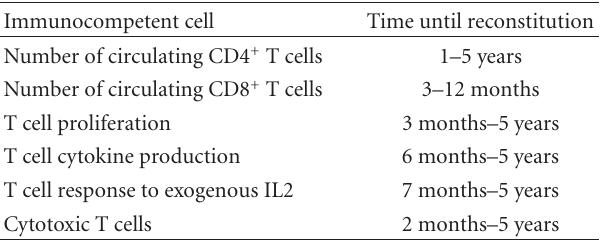
Table 2: T cell reconstitution after autologous stem cell transplan-